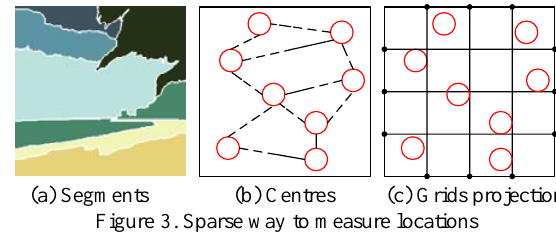
Figure 3. Sparse way to measure